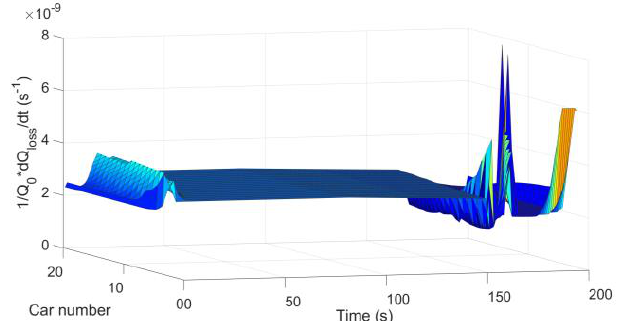
Figure 11. Vehicle battery capacity decline in situation 1.